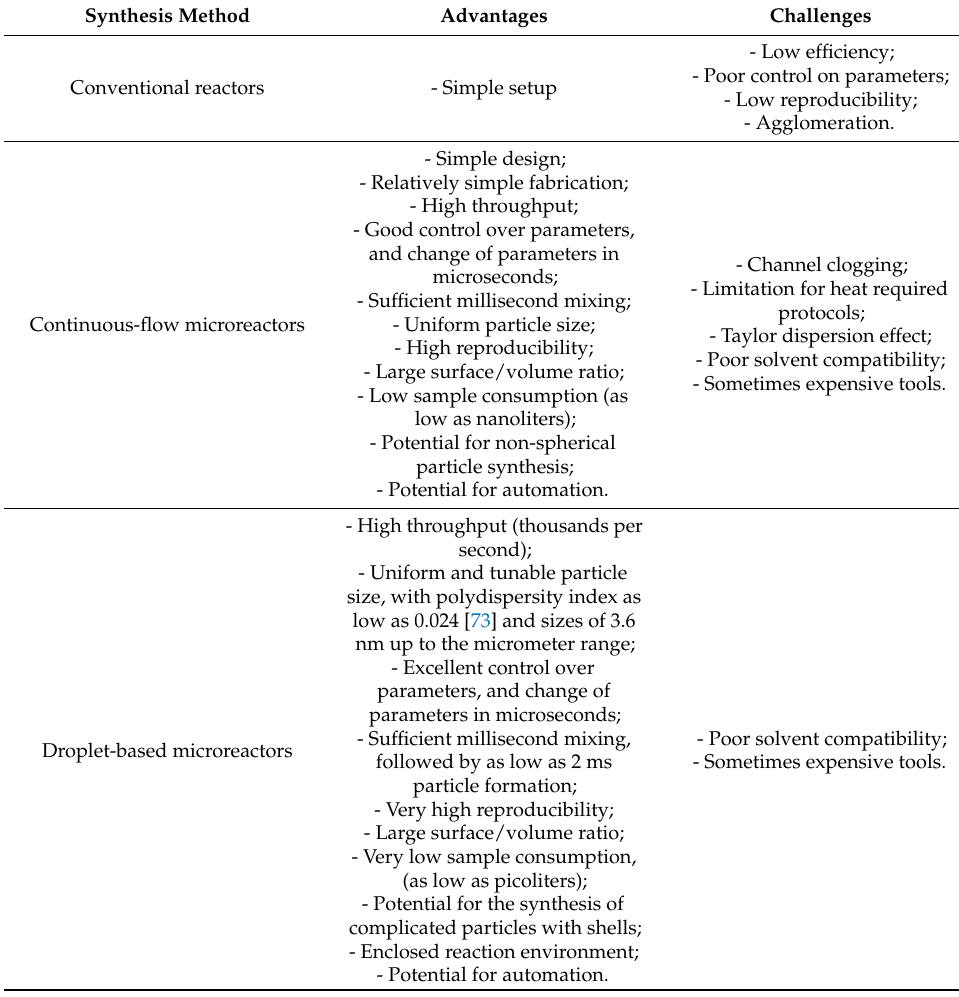
Table 2. Advantages and challenges of various nanoparticle synthesis